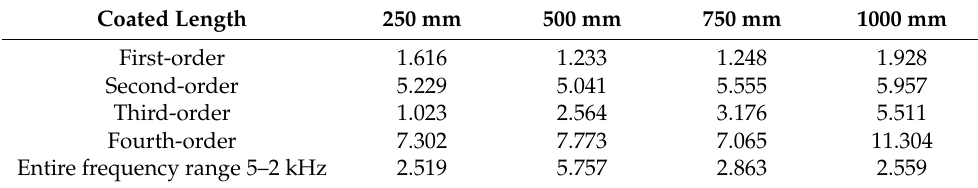
Table 5. Insertion loss ( IL ) of pipeline with different coated length (unit: dB). Coated